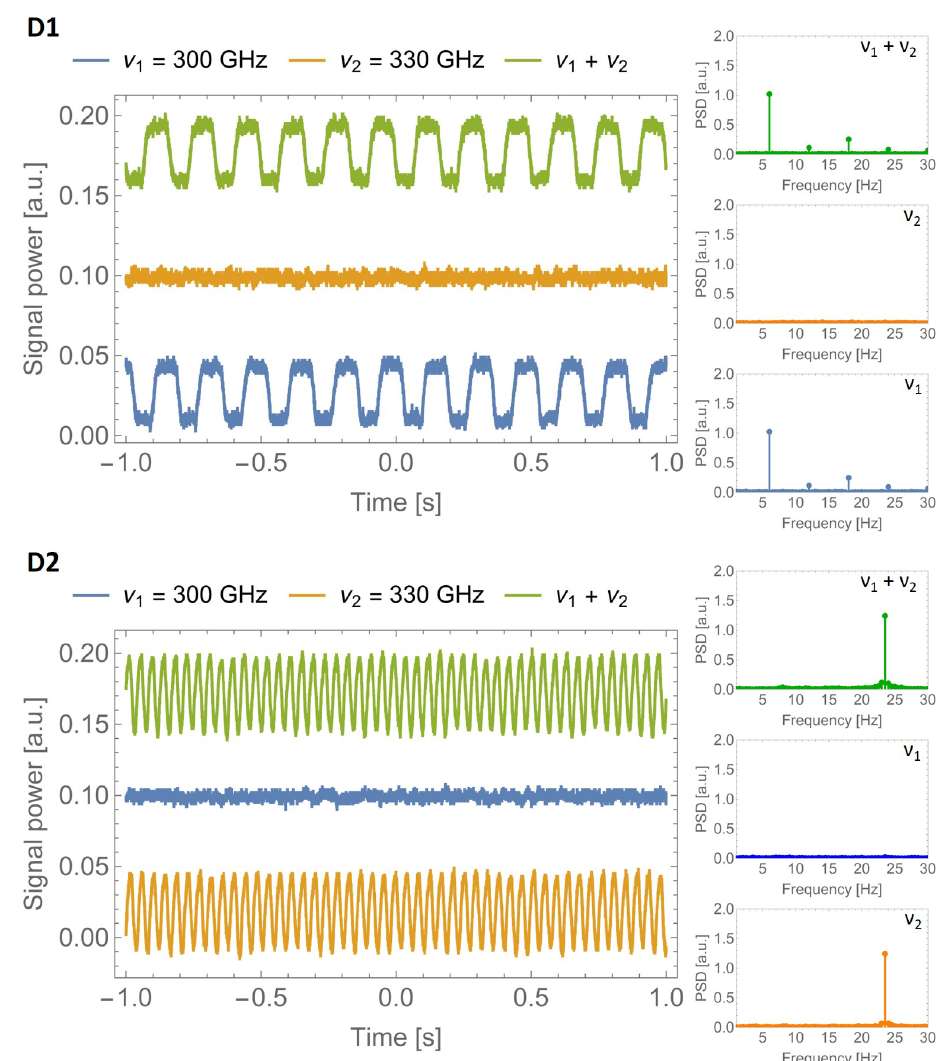
Figure 10. Measurements registered in two positions after the DOE—in D1 and D2. In each position, three cases have been measured: both sources are on (green), only a 300 GHz source is on (blue), and only a 330 GHz source is on (orange). The recorded intensity of signals in the time domain is plotted for both detector positions D1 (top left) and D2 (bottom left). The measurements were performed using the broadband detector. Additionally, power spectral densities of signals observed in the location D1 and D2 are illustrated on the